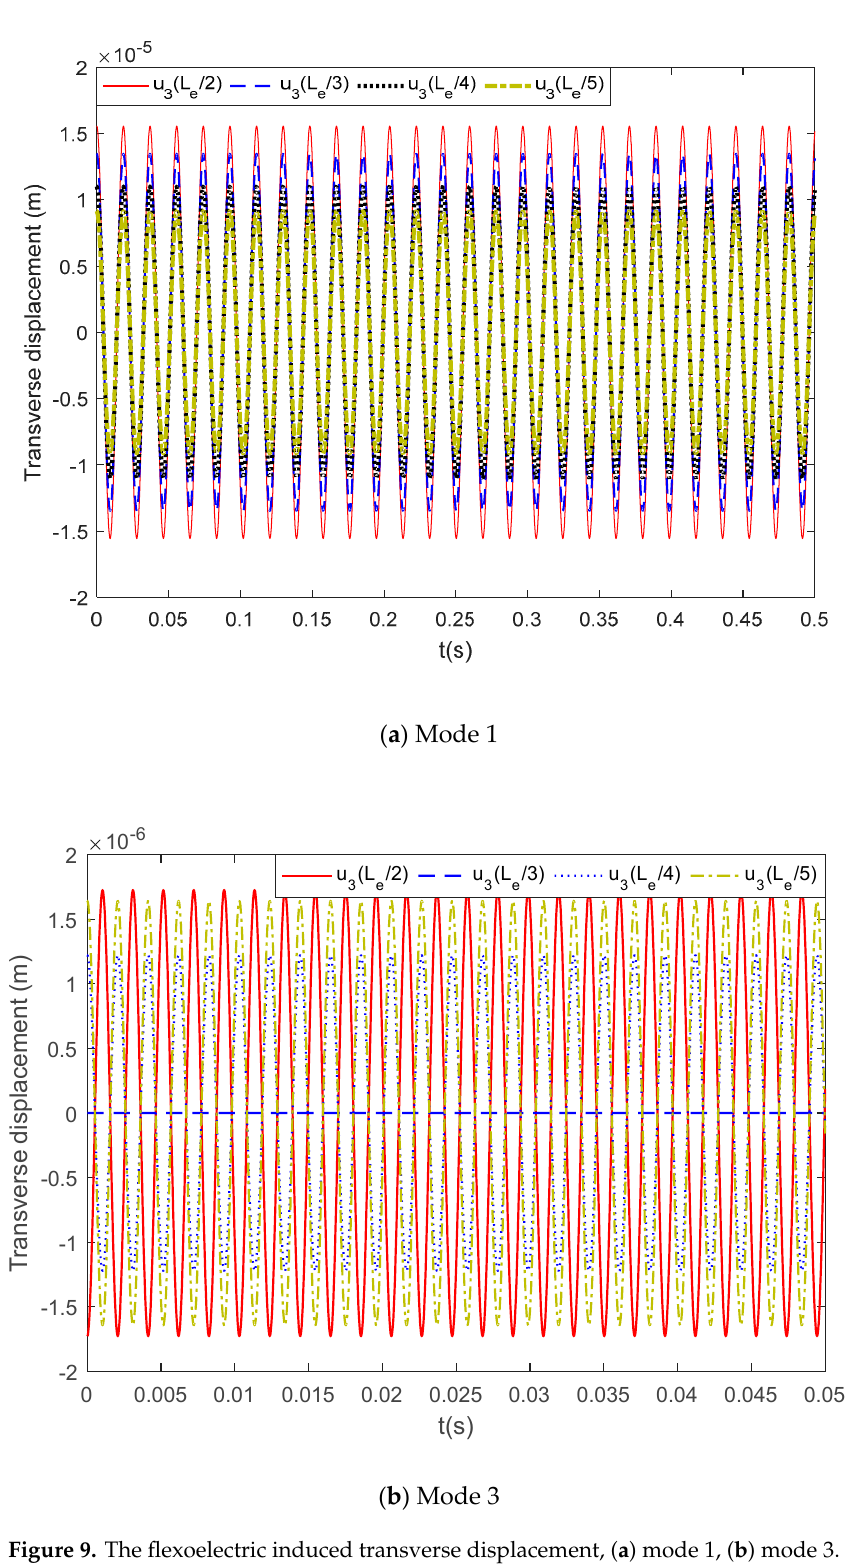
Figure 9. The flexoelectric induced transverse displacement, ( a ) mode 1, ( b ) mode 3.